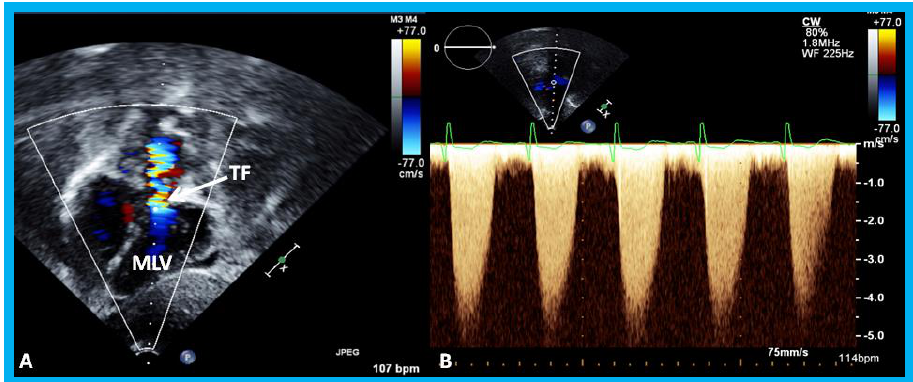
Figure 20. ( A ) Selected video frame from a subcostal four chamber view (similar to Figure 19B) with color-Doppler demonstrating turbulent flow (TF) in the pulmonary outflow tract. ( B ) Continuous wave Doppler recording across the pulmonary outflow tract demonstrates peak Doppler velocity of approximately 5 m / sec suggesting significant obstruction. MLV, morphological left ventricle. Reproduced from Yarrabolu T.R., et al.